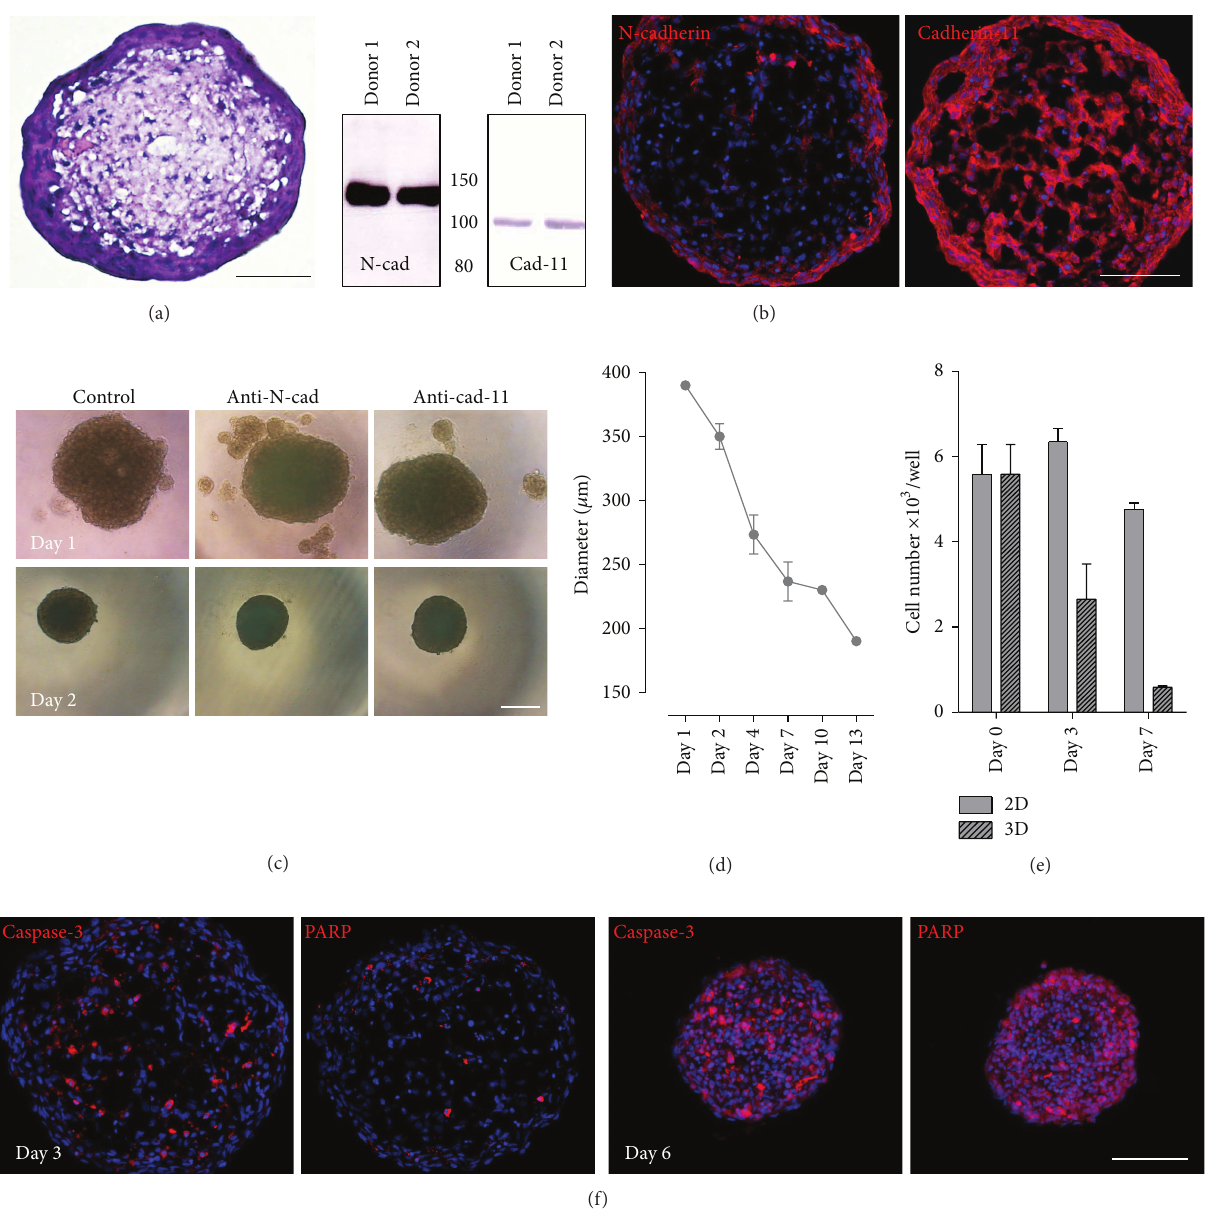
Figure 1: MSCs cultured in hanging drop plates form stable spheroids and do not proliferate. 5 × 10 3 mesenchymal stromal cells seeded in a hanging drop plate aggregate into a spheroid. (a) Hematoxylin/eosin staining of a spheroid cryosection shows a typical morphology with vast intercellular spaces in the central region and a tight peripheral MSC ring after 3 days of culture. (b) Human bone marrow MSCs express the cell adhesion molecules N-cadherin and cadherin-11 as shown by immunoblotting of lysates from confluent cell layers of two different donors. Using immunofluorescence staining, both cadherins were clearly detectable in MSC spheroids. (c) Aggregation of MSCs into spheroids was investigated in the presence of antibodies against N-cadherin and cadherin-11. On day 1, additional smaller aggregates were detectable as compared to the untreated cells, while all spheroids showed a similar morphology on the second culture day. (d) Determination of the diameter of the formed MSC spheroids with the AxioVision software revealed a continual decrease over two weeks. Spheroid sizes of four different donors were analyzed. Data are means ± SD. (e) Cell numbers of MSCs cultured in GMP-SFEM-CC100 medium as hanging drops (3D) or in conventional 2D plates were quantified in triplicate and are shown as means ± SD. The data are representative of three donors with comparable results. (f) Apoptotic cells in 3- and 6-day-old spheroids were detected by staining with specific anti-caspase-3 and anti-PARP antibodies. Cell nuclei were counterstained with DAPI. The immunofluorescence and light microscopy pictures are representative for MSC spheroids of at least three different donors. Scale bars: 100 𝜇 m (a, b, and f) and 250 𝜇 m